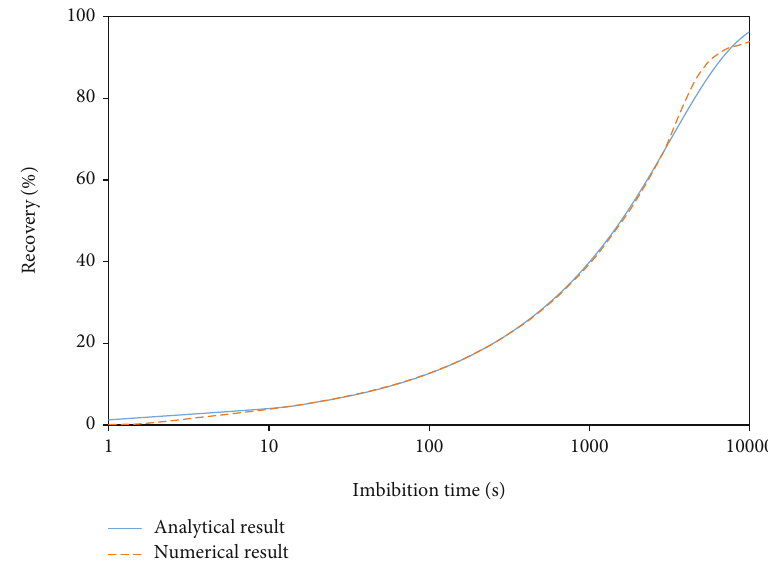
Figure 8: Comparison of the oil recovery results obtained using the analytical and numerical